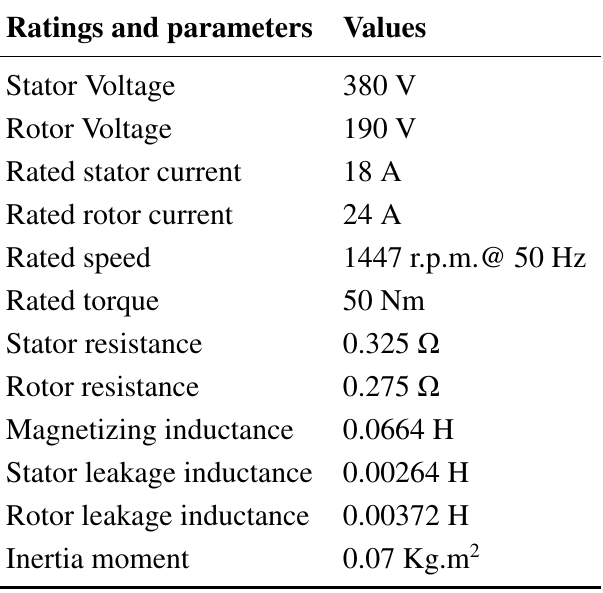
Table 1. Ratings and parameters of the DFIG (Leroy